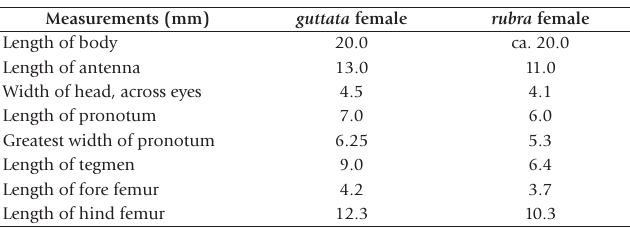
Table 1. Measurements of female Mopla guttata and M. rubra (Henry 1940).